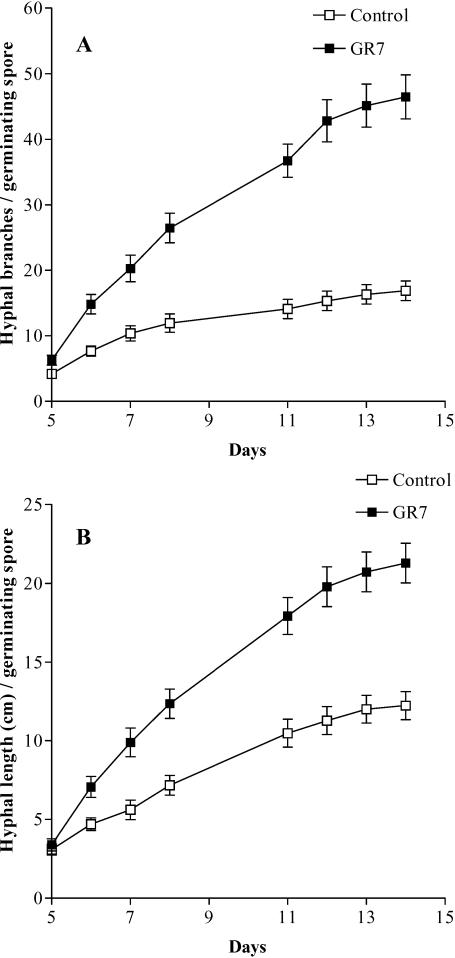
Time-Course Analyses of
Gi. rosea Hyphal Branching (A) and Growth (B) Treated with 10
−7 M GR7 in Methanol:Water (v/v) or with Methanol:Water (v/v) (Control)
Number of hyphal branches and total hyphal length (including hyphal branches) were recorded and cumulated from day 5 to 14. Twenty spores were analysed per treatment. This experiment was repeated three times with similar results. Error bars show SEM.